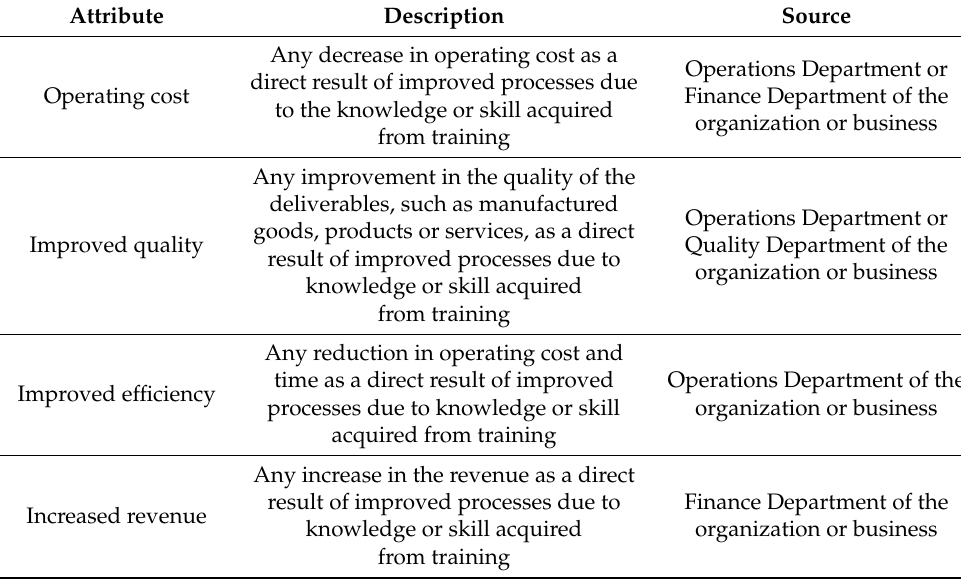
Table 4. Quantitative data for business